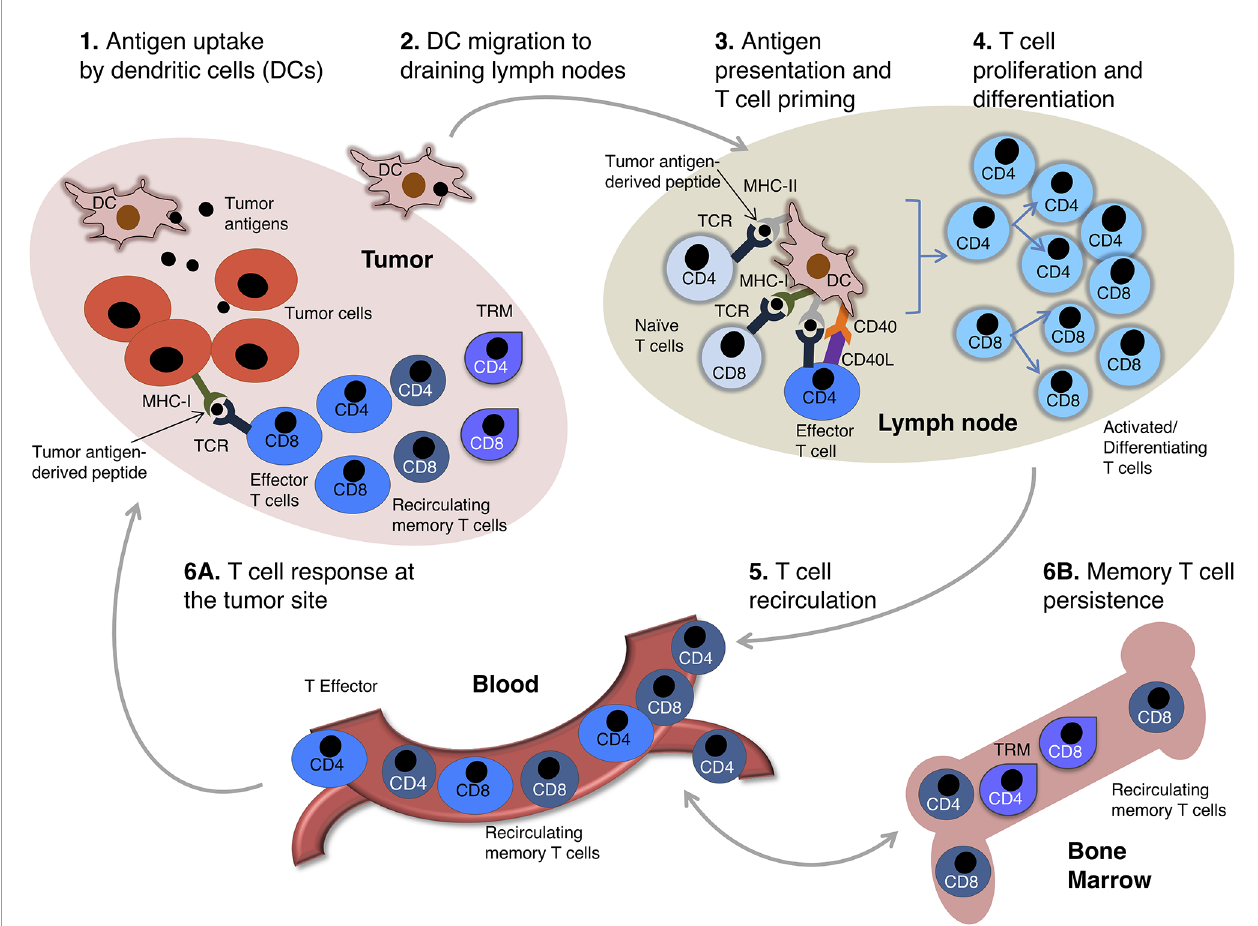
FIGURE 1 | The circuit of anti-tumor T cell immunity. A scheme of anti-tumor T cell response is depicted. Intratumoral DCs uptake antigens released by damaged/ dying tumor cells ( 1 ). DCs get activated and migrate to tumor draining lymph nodes (LNs) ( 2 ) wherein they present tumor antigen-derived peptides in the context of MHC molecules, plus costimulatory signals, to naïve tumor-speci fi c T cells. Tumor antigen-derived peptides presented in MHC-II and MHC-I molecules are recognized by CD4 and CD8 T cells, respectively. Activated CD4 T cells differentiating into effector cells up-regulate CD40L and provide help for naïve CD8 T cells by modulating DC costimulatory capability (so-called DC “ licensing ” , mediated by CD40L-CD40 interaction) (1 – 4). Licensed DCs are enabled to provide full costimulation for naïve CD8 T cell priming ( 3 ) (note that DC-provided costimulatory signals for T cell priming are not depicted for simplicity). Activated tumor-speci fi c CD4 and CD8 T cells proliferate and differentiate ( 4 ), and migrate out of LNs into the blood stream ( 5 ). The differentiated progeny includes effector and memory T cells, which extravasate from the blood and enter the tumor sites ( 6A ). Tissue-resident memory T cells (TRM) are non-migratory cells that persist in the tumor (5), whereas recirculating memory T cells go back to circulation and migrate all over the body (6). They preferentially accumulate in the bone marrow (BM), a key organ for long- term memory T cell maintenance (7, 8) ( 6B